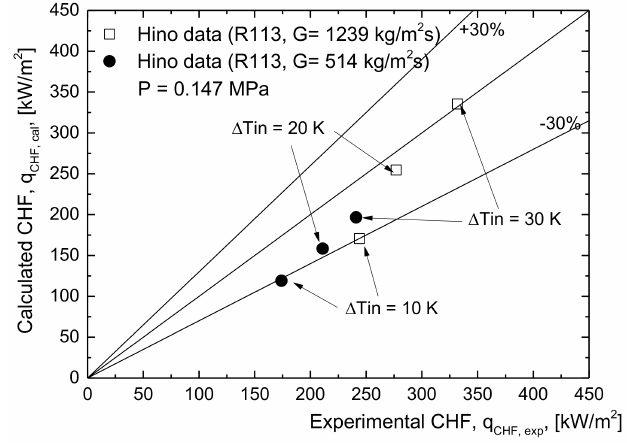
Figure 6. CHF prediction in an annulus for Hino data (Saha − Zuber model for NVG point).